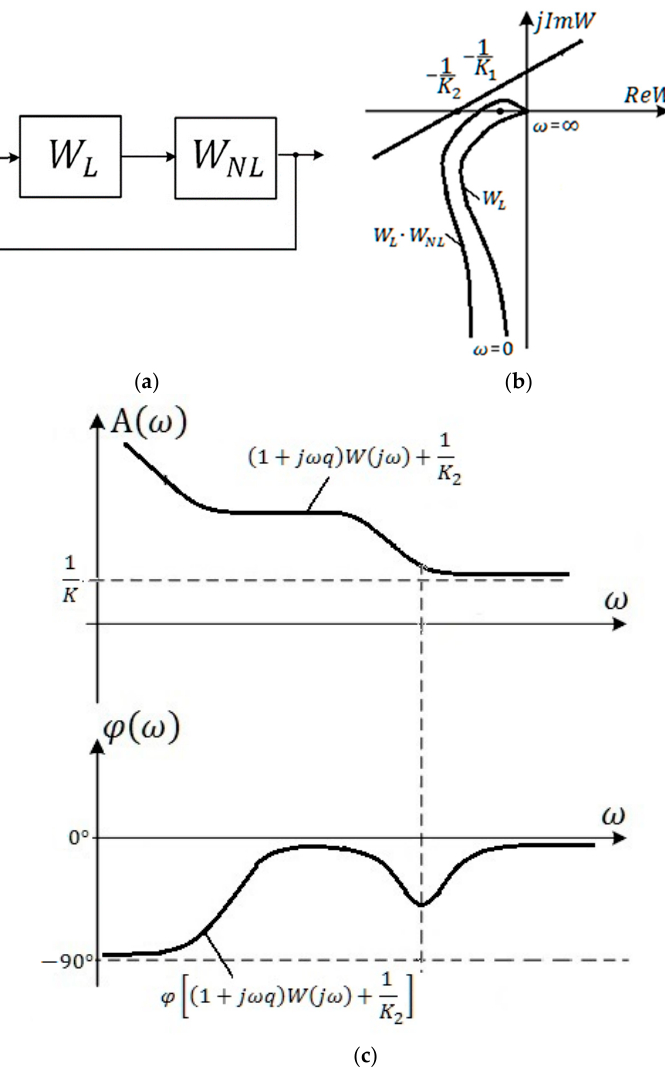
Figure 12. Structure of nonlinear ACS ( a ) and stability condition for it according to the criterion of V.M. Popov for frequency hodographs ( b ) and logarithmic frequency characteristics ( c ). Example 2. There is a high-order automatic control system with mechanical non- linearity.